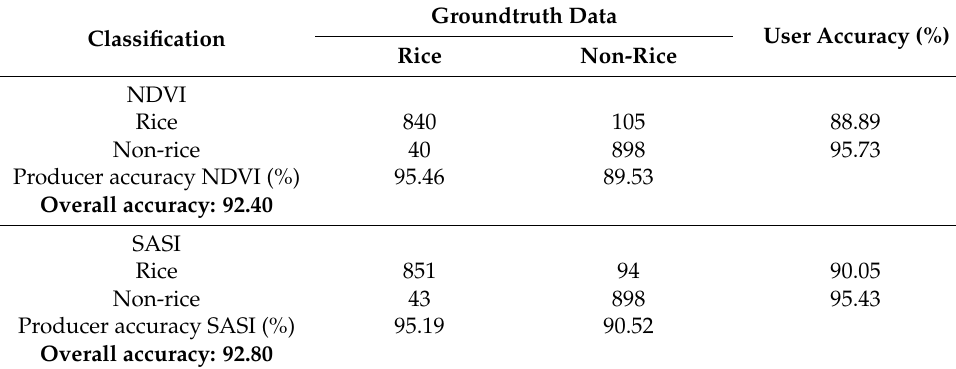
Figure 7. Examples of NDVI ( a , c , e ) and SASI ( b , d , f ) annual patterns for each category in Ebro Delta, Albufera, and Orellana, respectively. Green color indicates annual profiles similar to the reference rice profile. Table 1. Accuracy assessment of the classification for NDVI and SASI in the Ebro Delta (2012).